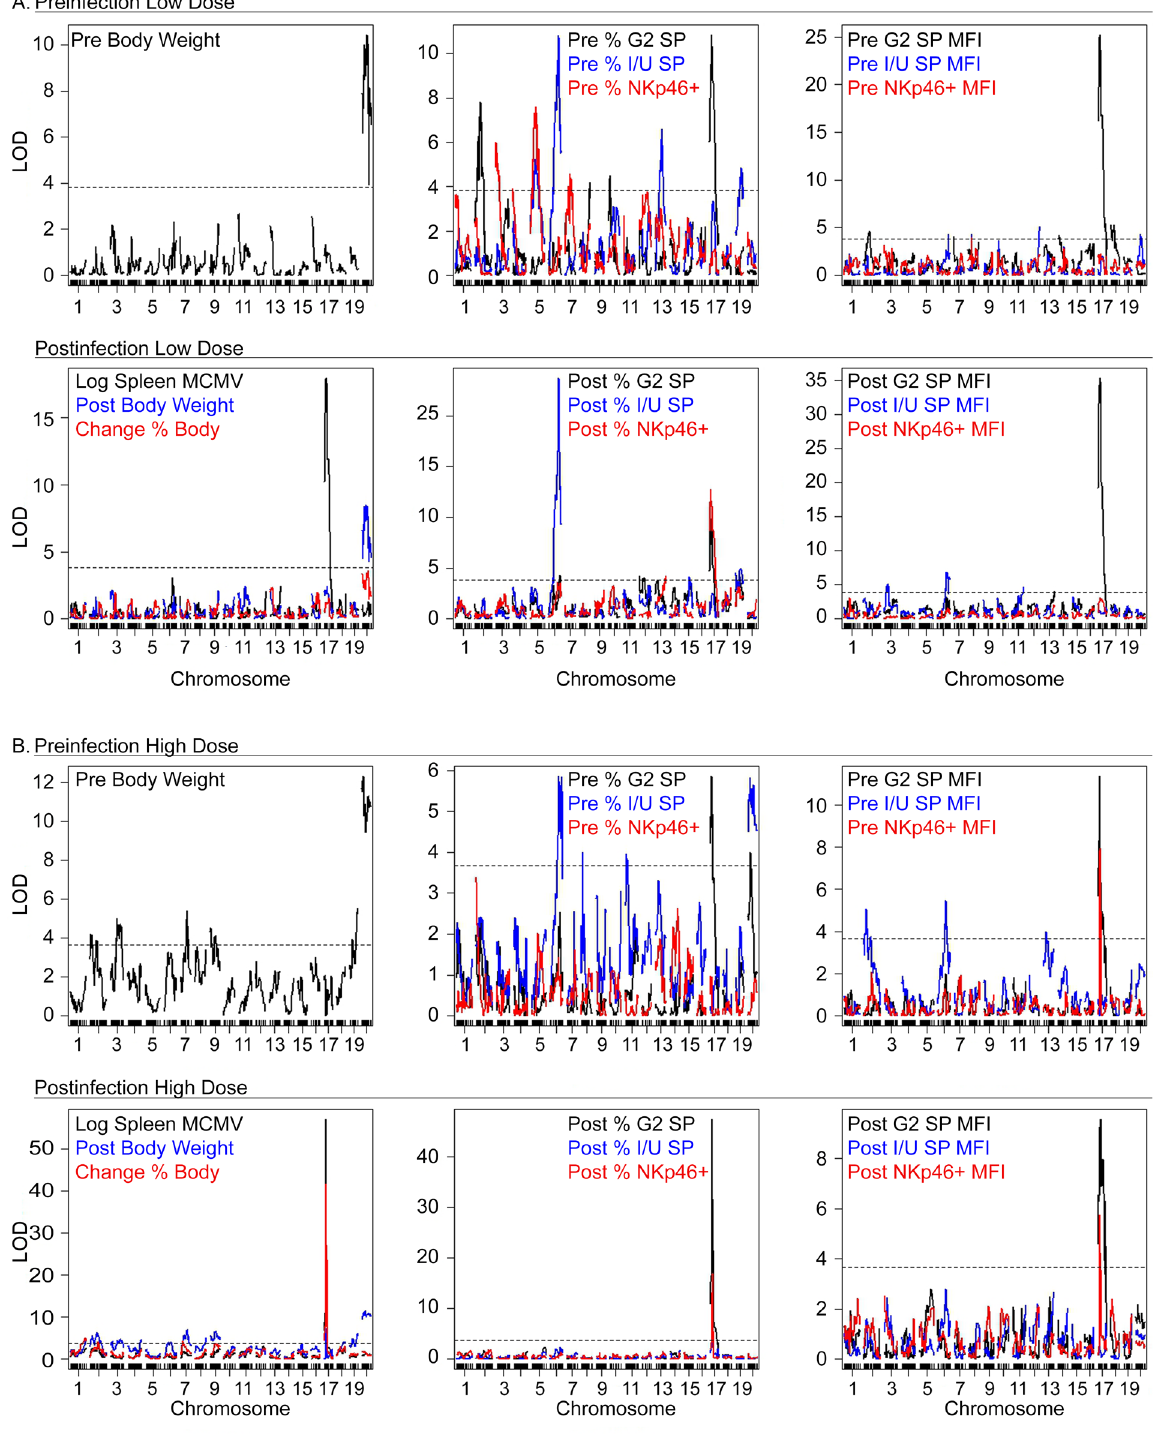
Fig 1. Genomic profiling of MCMV immunity. Multiple QTL chr maps for na ï ve and either LD (A) or HD (B) infected cohorts of mice. Shown are color-coded LOD profiles for the indicated pre- and postinfection traits for both cohorts.